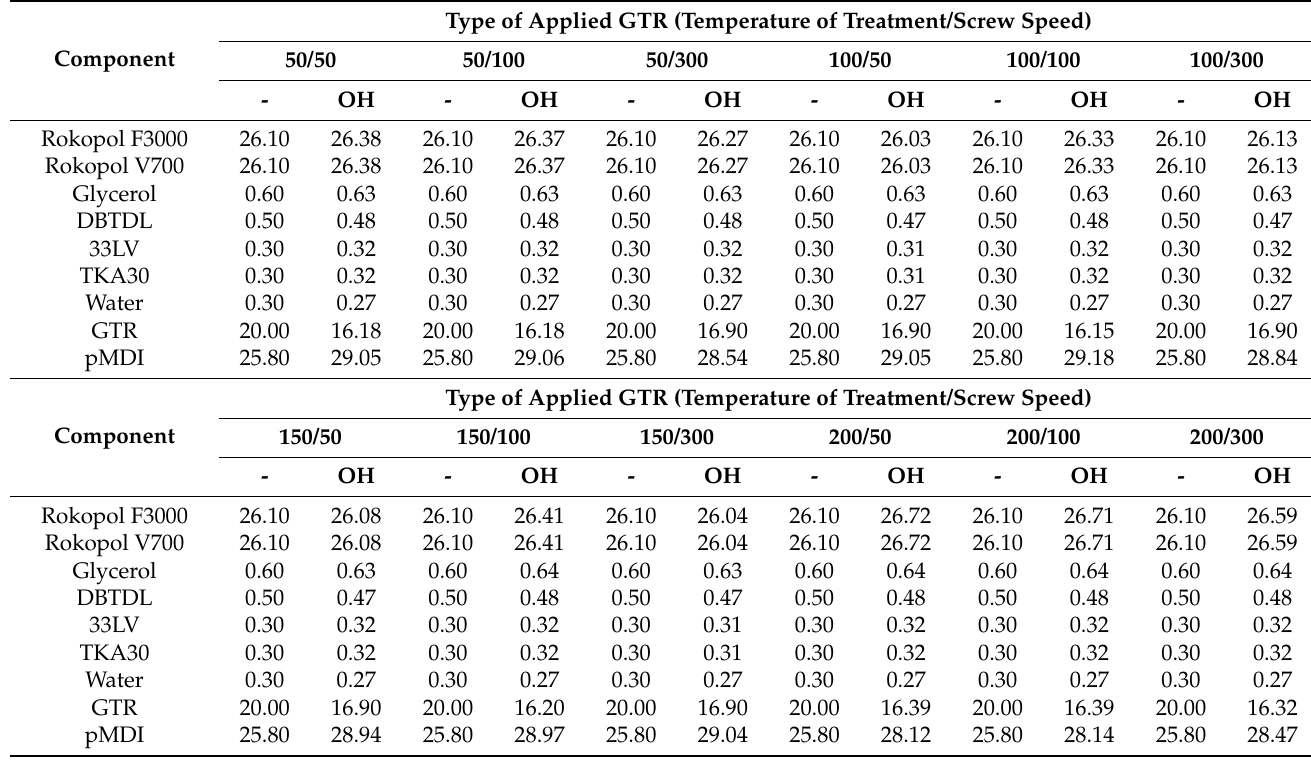
Table 2. Formulations of PU/GTR composite foams investigated in the presented